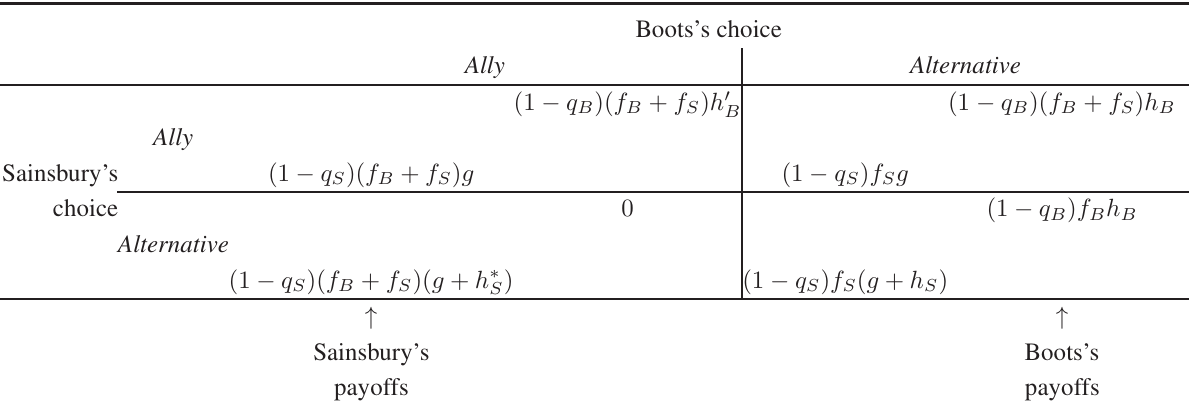
Table 2. Initial payoffs with a third